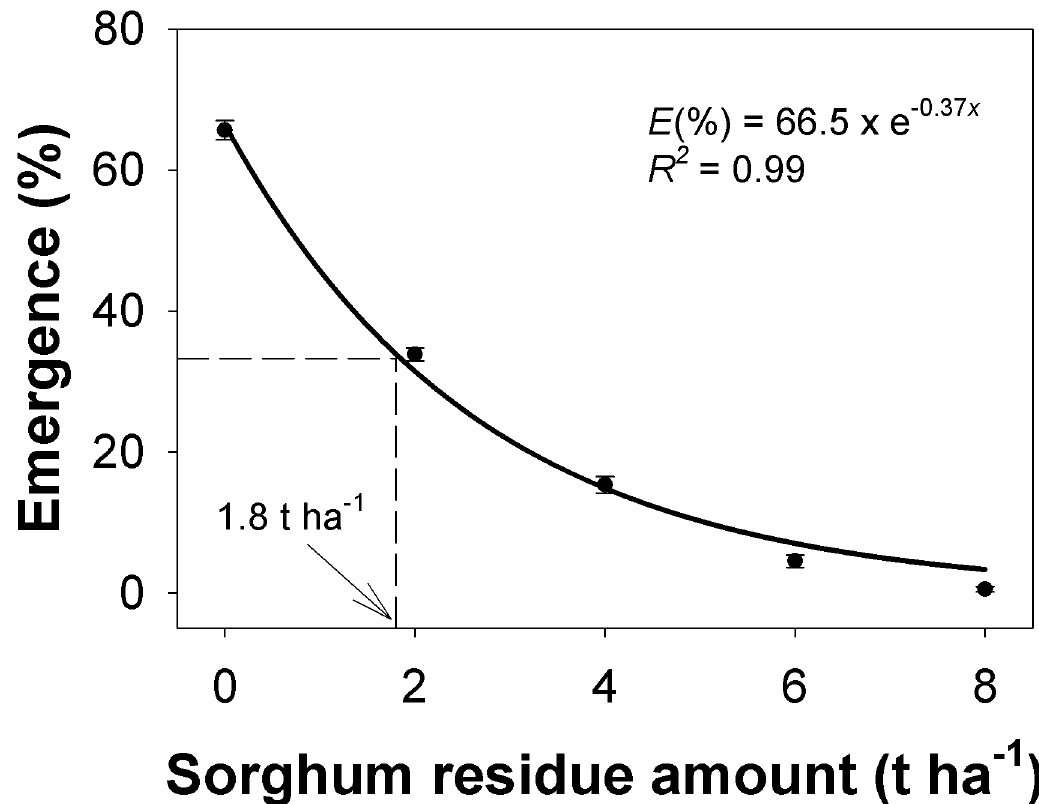
Fig 6. Effect of sorghum residue amount on seedling emergence of Chloristruncata after 21 d of incubation at 25/15˚C day/ night temperature. The line represents an exponential decay model fitted to the data. The arrow shows the sorghum residue amount to inhibit 50% emergence. Vertical bars represent standard error of